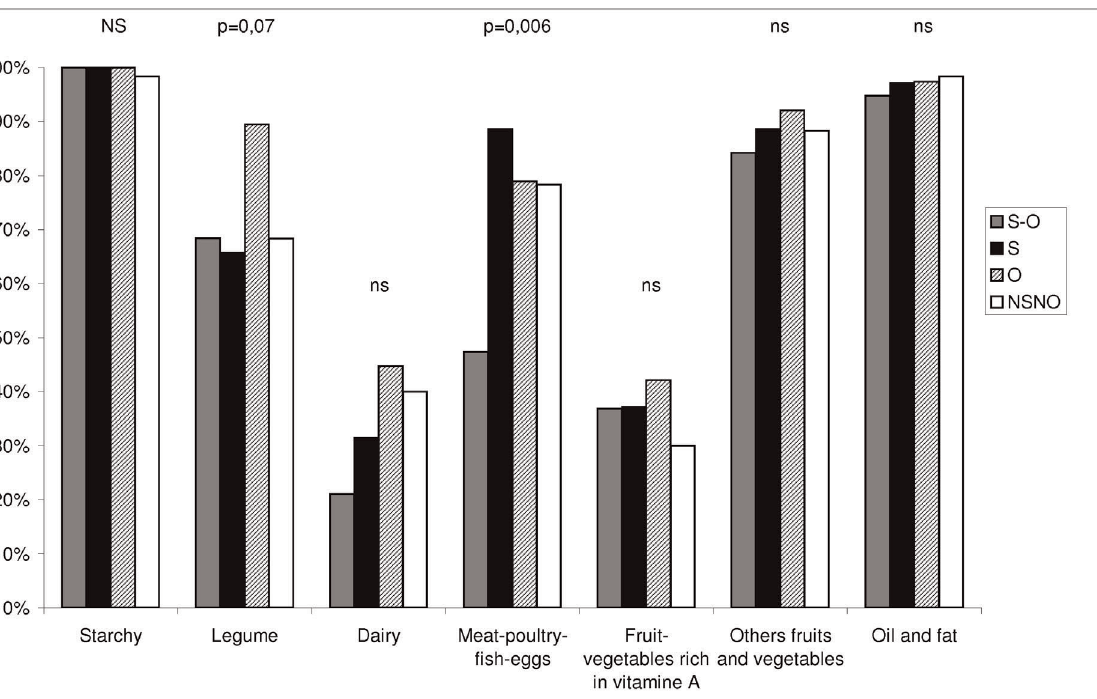
Figure 2. Mean percentage, per group, of children who consumed one item of the food group. S-O: stunted-overweight children (n=18), S: Stunted children (n=34), O: Overweight children (n=37), NSNO: Non-stunted-Non Overweight children (n=59). p-values correspond to the Pearson’s chi-squared test; ns= non significant. Relationships do exist between the consumption of ‘‘meat-poultry-fish-eggs’’ and the different nutritional status of children (p=0.006): S-O children are less likely to consume these items than NSNO (p=0.01), O (p=0.01) and S (p=0.001) children.